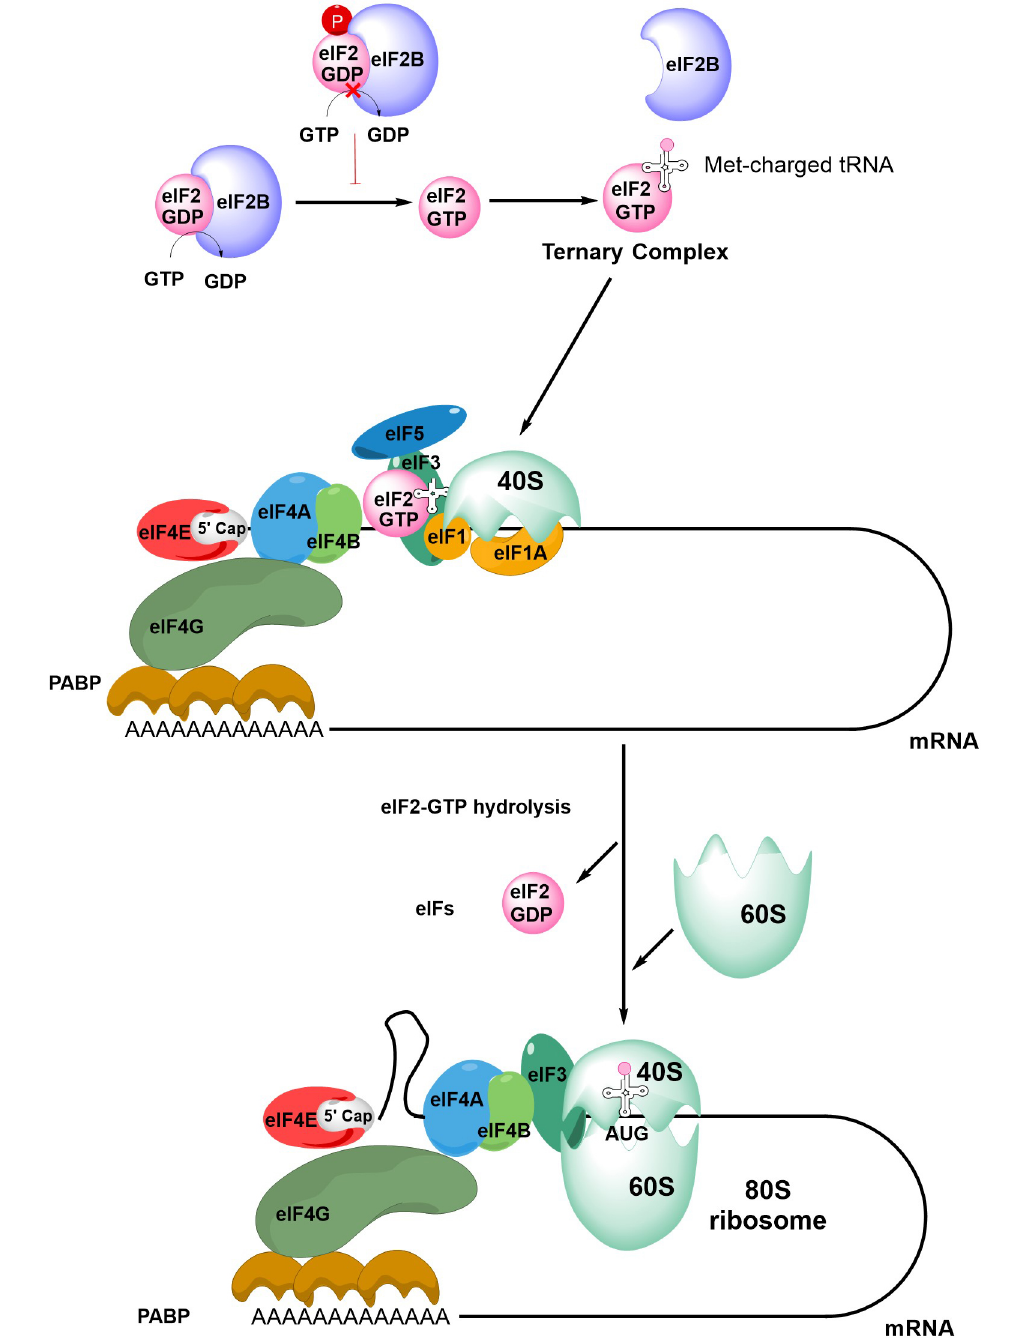
Figure 2. An overview of mRNA translation initiation. The Figure shows some of the key steps in initiation of translation. The process initiates with the joining of the eIF4F complex (eIF4A, eIF4E and eIF4G), the tertiary complex, the 40S ribosome subunit and accessory eIFs. Interactions between eIF4G and PABP lead to closed-loop formation/mRNA circularization. The subsequent steps of scanning, initiation codon recognition and large ribosome subunit joining are accompanied by eIF2-GTP hydrolysis, release of eIF2-GDP and other eIFs. Note figure is illustrational and does not show all intermediate steps. See text for